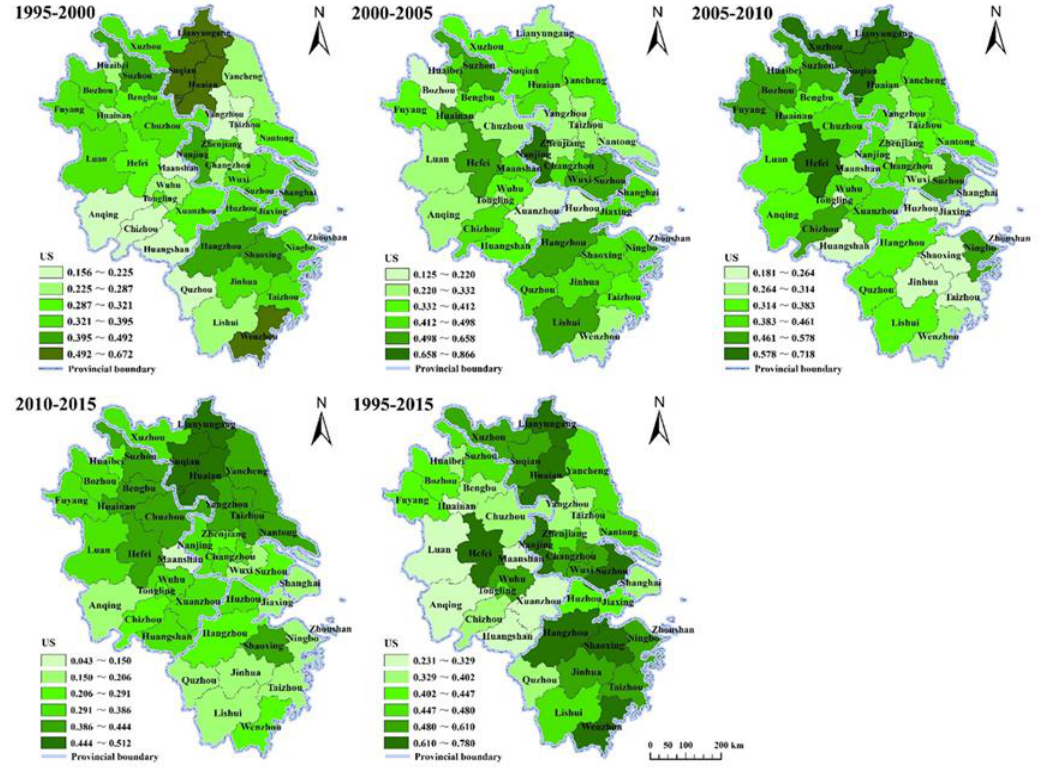
Figure 9. Urbanization speed (US) values of the YRD region from 1995 to 2015.